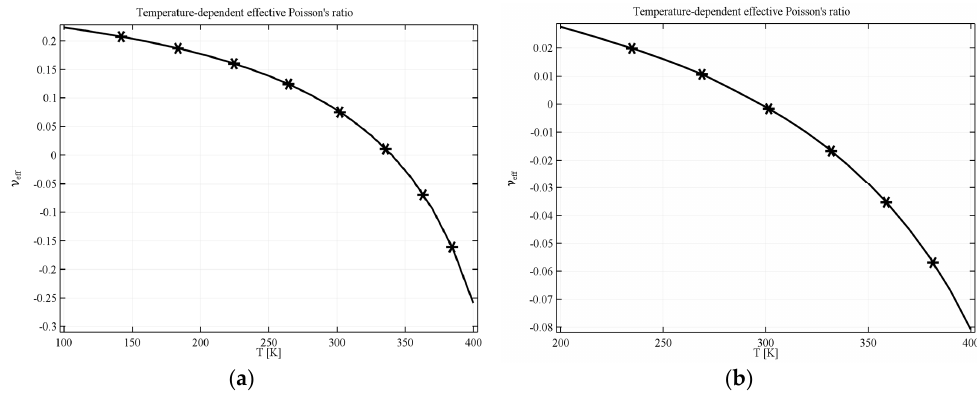
Figure 4. Effective Poisson’s ratio for AT geometry with filled voids in the case of ( a ) computational filling material; ( b ) real filling material. Parameters of the geometry: L = 1, R = 0.33, r = 0.25.